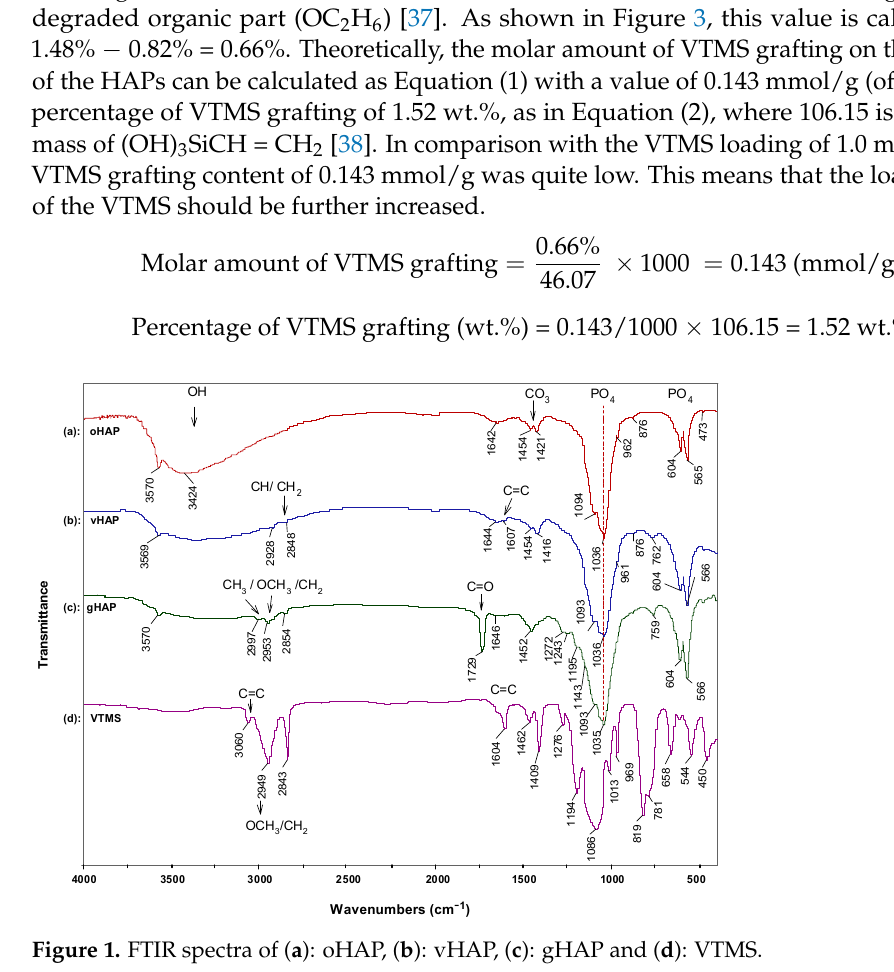
Figure 1. FTIR spectra of ( a ): oHAP, ( b ): vHAP, ( c ): gHAP and ( d ): VTMS. For the PMMA/vHAP nanocomposite (collected after the first centrifugation) and the gHAP sample, the TGA and DTG curves (in Figure 4) exhibited two stages of de- composition. The first decomposition stage occurred from 30 ◦ C to 325 ◦ C, due to the evaporation of moisture (similar to oHAP and vHAP), residual monomer and PMMA oligomers. The second stage was the decomposition of the organic moieties (PMMA and VTMS), occurring from 325 ◦ C to 750 ◦ C, which can be observed more clearly in the DTG diagrams of the PMMA/vHAP nanocomposite and the gHAP in Figure 4b. The weight loss in this stage was 12.92% for the PMMA/vHAP, which can be attributed to the total PMMA content in the nanocomposite. The weight loss of 5.85% in the second stage for the gHAP sample (from 325 ◦ C to 750 ◦ C) can be attributed to the grafted PMMA content and the strong physical attachment of the PMMA molecules on the surface of the gHAP nanoparticles [35,36]. In this case, the weight losses due to the degradation of the VTMS and the HAP were mostly